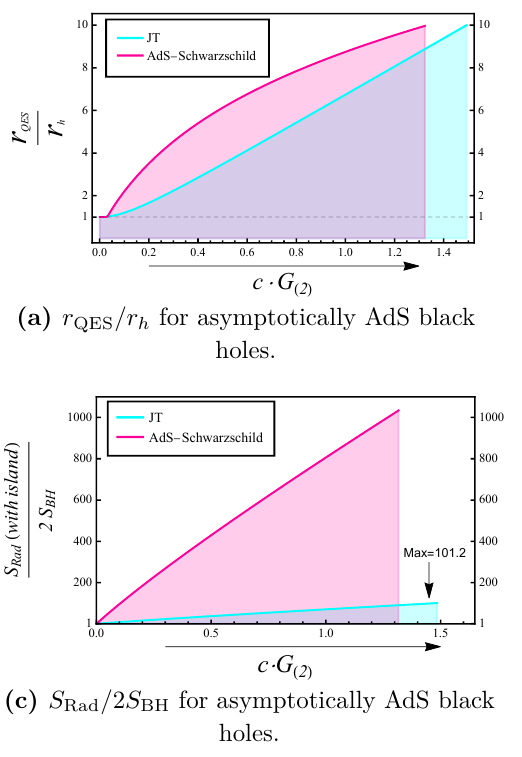
Figure 8. Curves of the QESs and their corresponding late-time radiation entropy with respect to (for asymptotically AdS black holes). Diagrams are plotted with setting r c · G (2) = 0 Λ = 10 r , G = 1 / 8 π ( λ = 10 − 2 for the AdS-Schwarzschild black r ∗ h (2) b